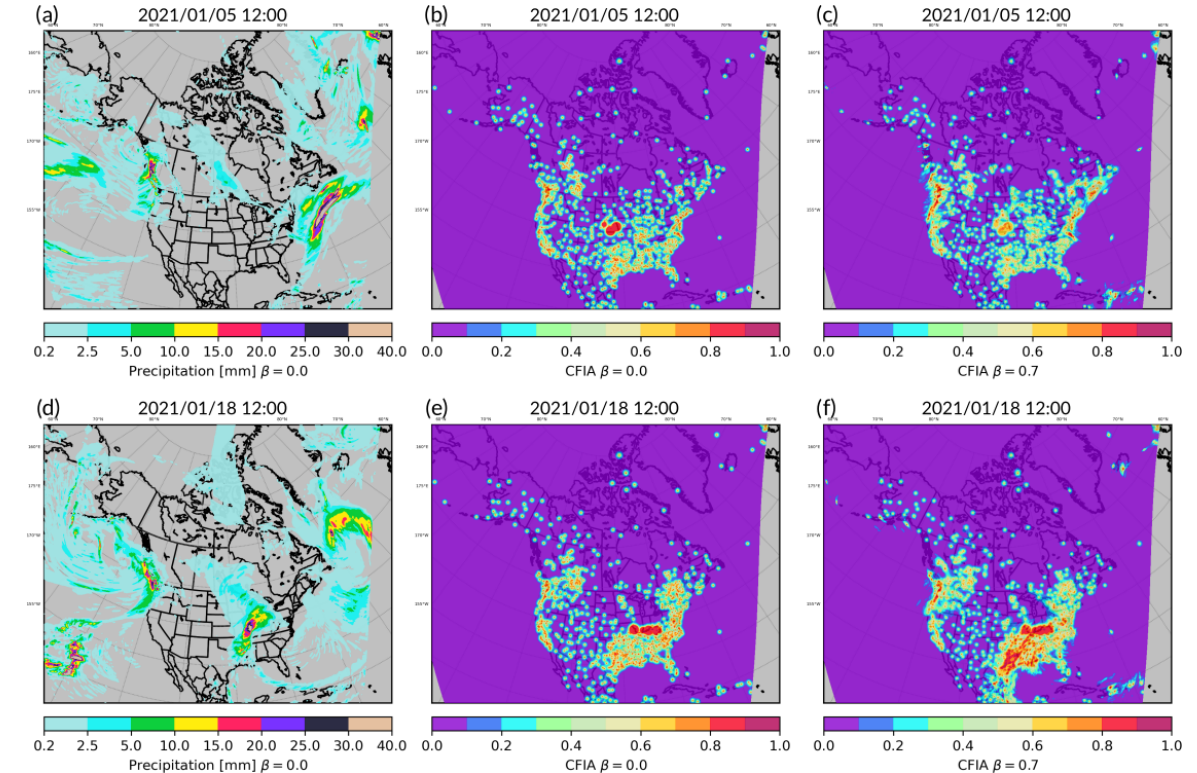
Figure 8. The precipitation field (a, d) from CaPA and the associated CFIA values (b, e) for 5 and 18 January 2020, both valid at 12:00UTC. Panels (c) and (f) show the CFIA for the same date but using the hybrid approach with a high contribution of the REPS – here with β = 0 .